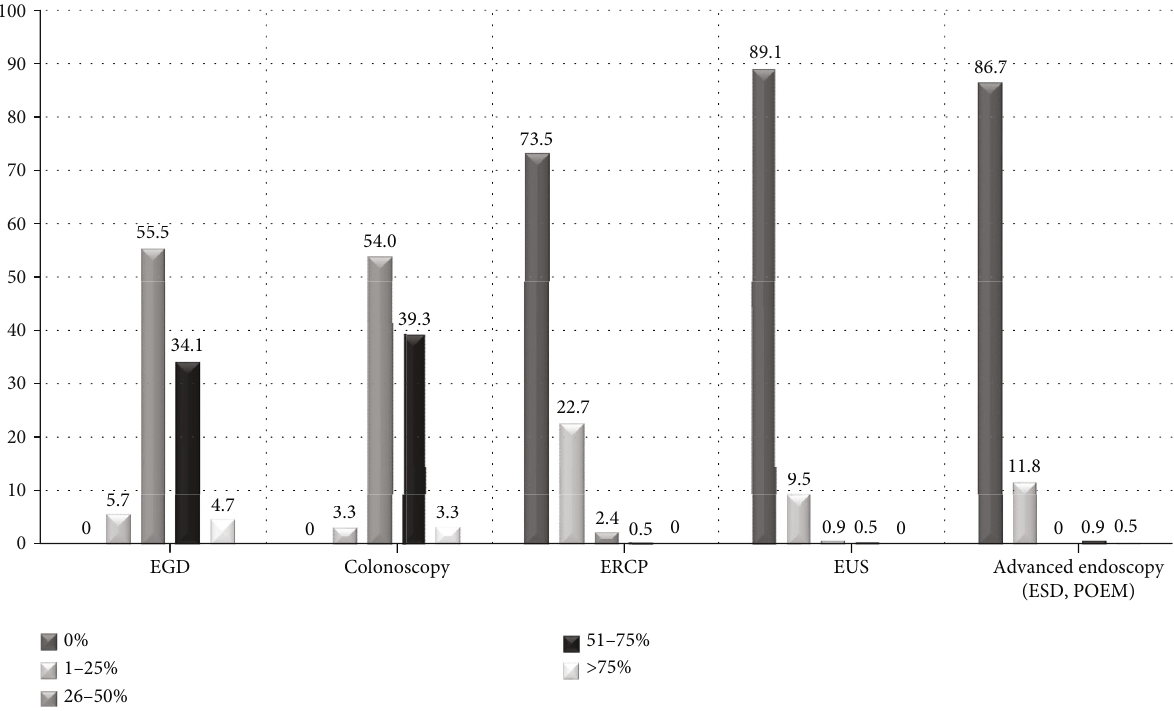
Figure 2: Participants ’ workload by endoscopic procedure. Data are expressed as percentage according to prede fi ned ranges (0%, 1-25% of procedures, between 26 and 50%, between 51 and 75%, and over 75%). EGD: esophagogastroduodenoscopy; ERCP: endoscopic retrograde cholangiopancreatography; EUS: endoscopic ultrasound; ESD: endoscopic submucosal dissection; POEM: per oral endoscopic myotomy.